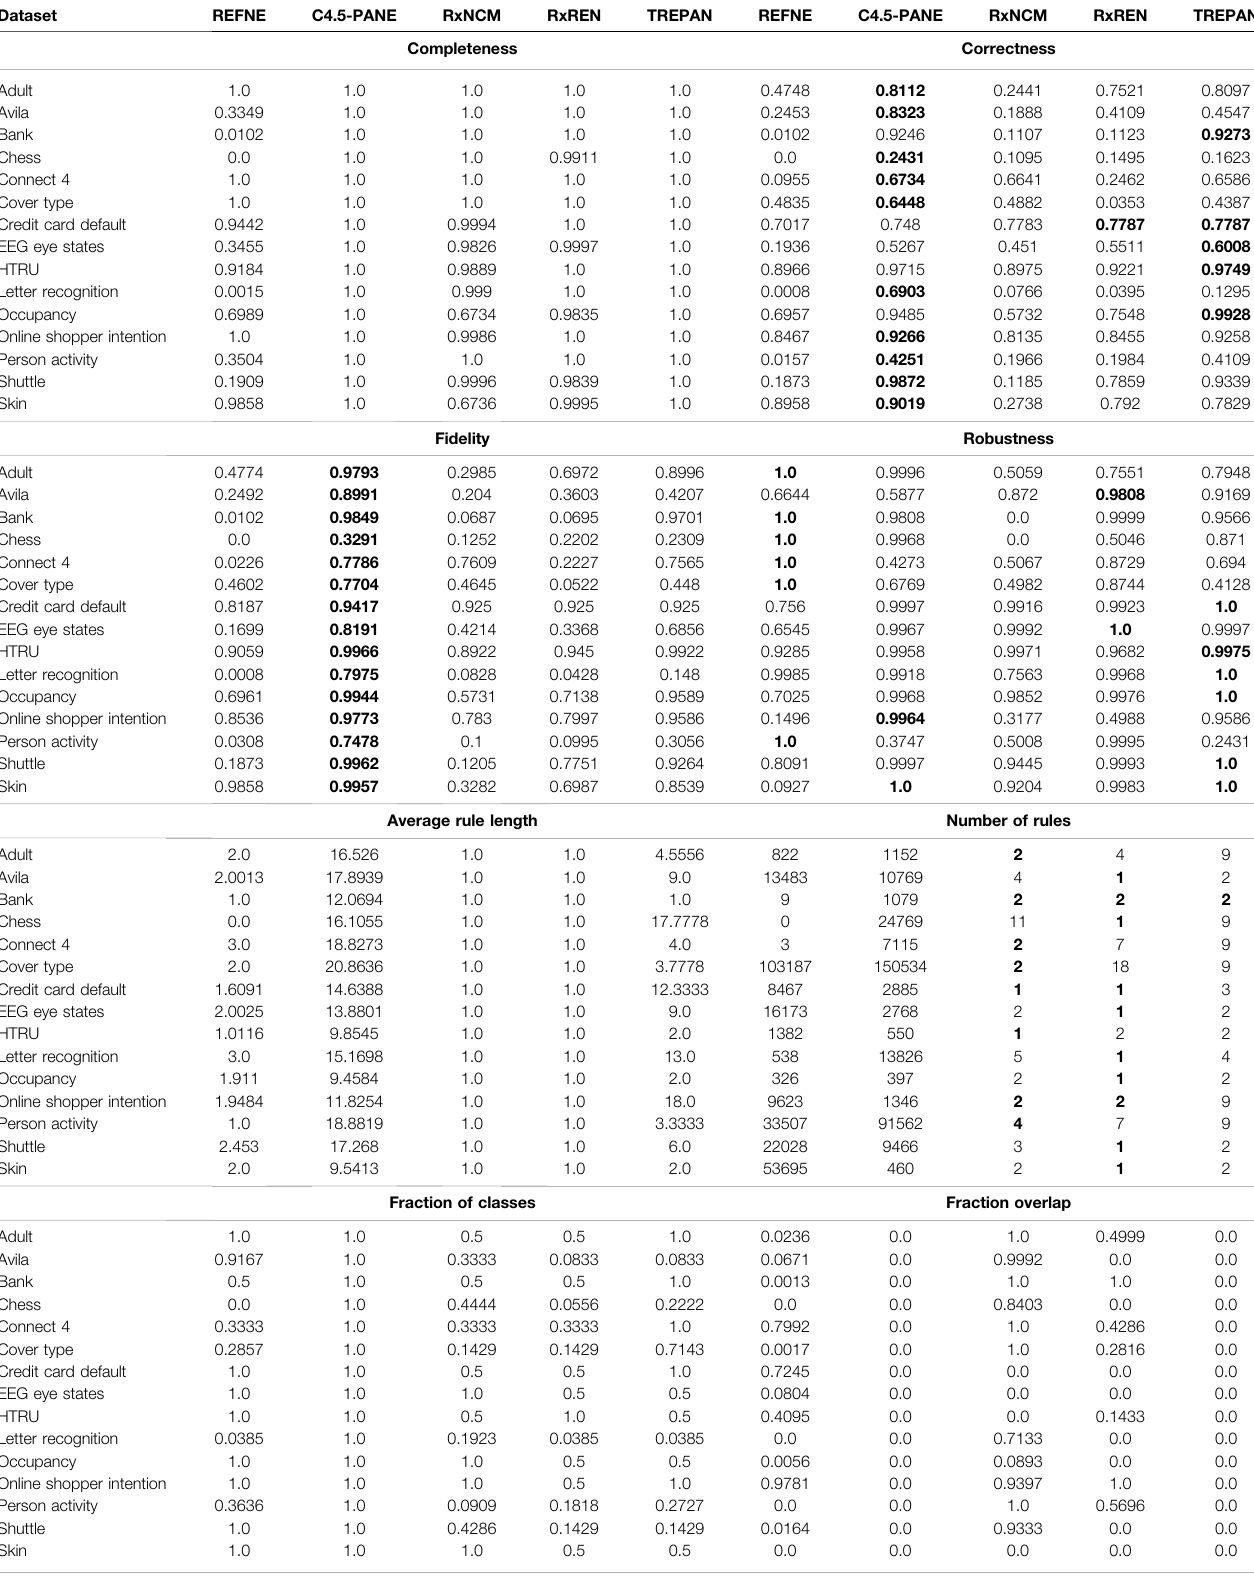
TABLE 4| Quantitativemeasuresofthedegreeofexplainabilityoftherulesetsautomaticallygeneratedby5rule-extractormethodsover 15datasets accordingto8metrics.